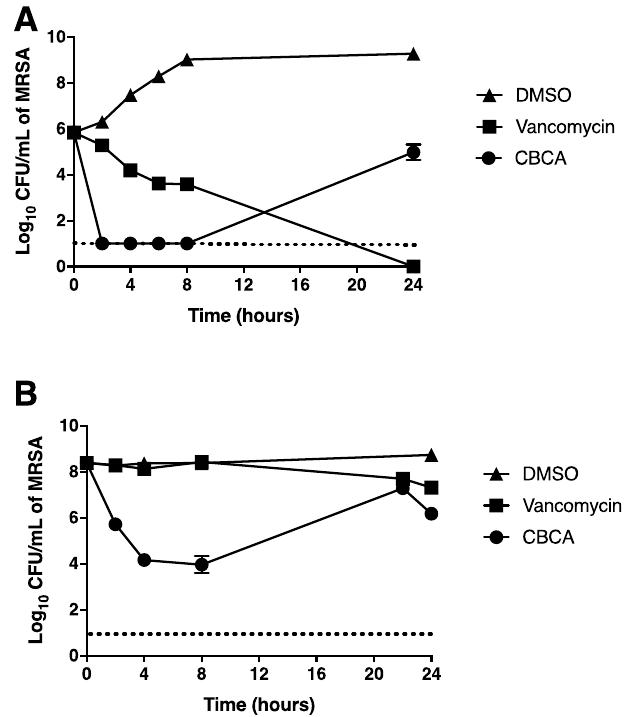
Figure 1. Time-dependent killing of methicillin-resistant Staphylococcus aureus (MRSA). MRSA was grown to OD 600 0.001 ( A ) or 0.6 ( B ) and incubated with cannabichromenic acid (CBCA) (40 µ M), vancomycin (30 µ M), or DMSO (1%). At indicated time points, aliquots of cultures were serially diluted and plated for enumeration of viable bacteria (CFU / mL). Error bars represent the standard error obtained from triplicate samples. Dashed lines indicate the level of detection.